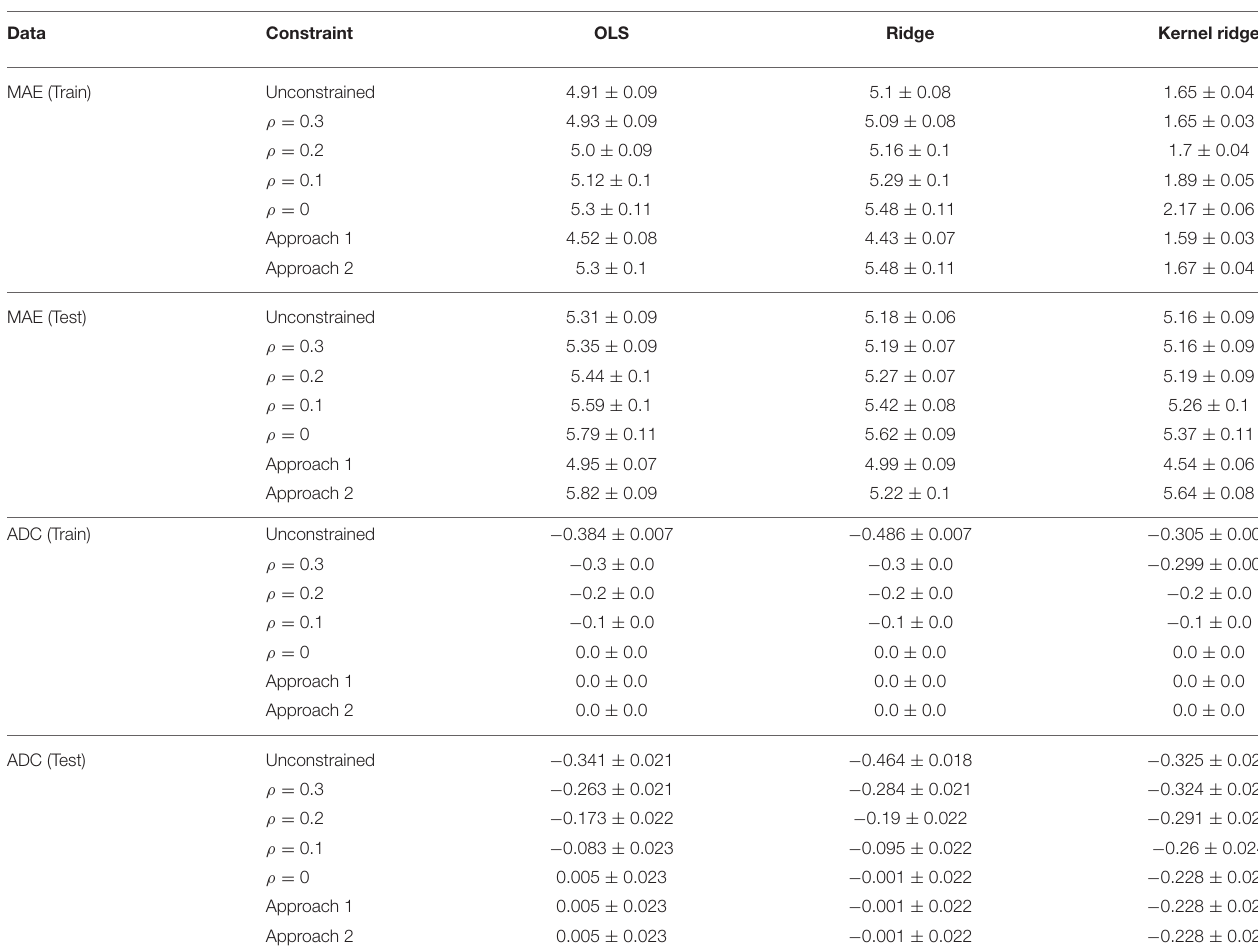
TABLE 2 | Mean absolute error (MAE) and age delta correlation (ADC) for different types of correlation constraints and regression